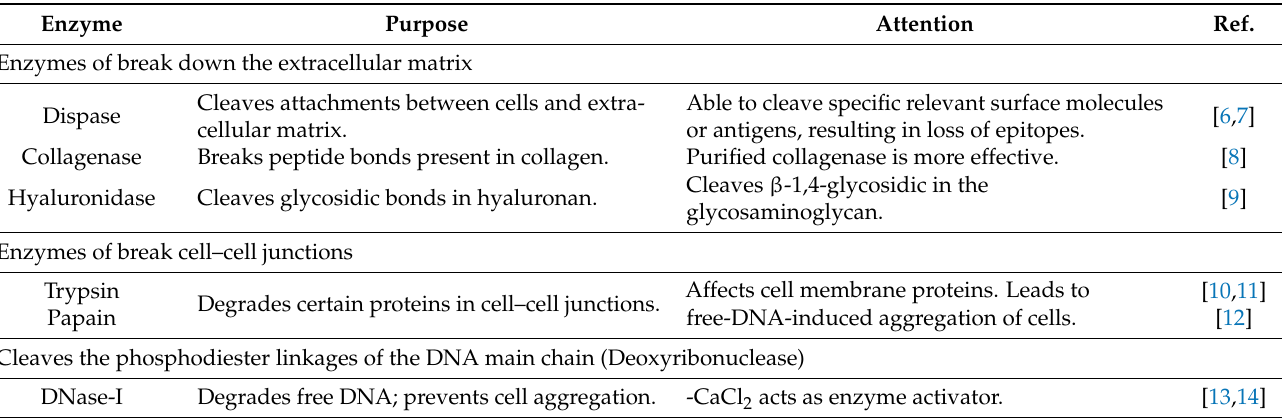
Figure 2. Schematic representation of the preparation of single-cell suspension from solid tissue. Tissues are composed of cells embedded in the extracellular matrix, which are sup- ported by the cell–cell connections of the extracellular matrix, a variety of proteins and other biomolecules. Proper digestion and the removal of these proteins and other biomolecules from cell suspensions requires specific enzymes. The digestive enzymes that play an important role in the decomposition of solid tissue are shown below (Table 1) [5]. Table 1. Digestive enzymes in the breakdown of solid tissue.